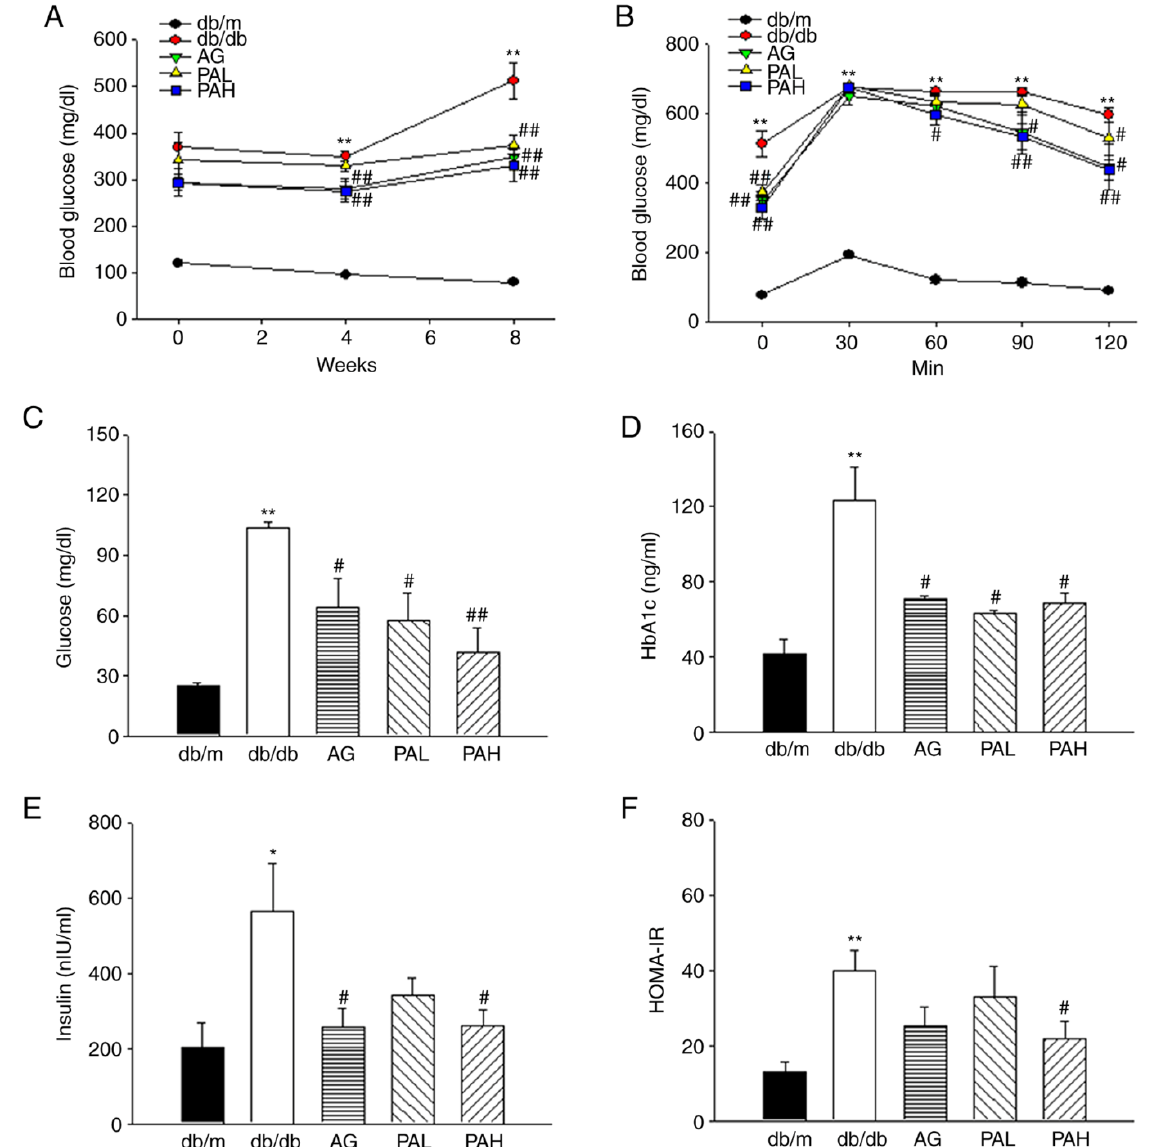
Figure 3. Effects of ER-PA on blood glucose ( A ); oral glucose tolerance test ( B ); glucose ( C ); HbA1c ( D ); insulin ( E ) and HOMA-IR ( F ). Values are expressed as mean ± standard error of the mean ( n = 8). * p < 0.05, ** p < 0.01 vs. db/m; # p < 0.05, ## p < 0.01 vs. db/db. PA , Polygoni avicularis ; HbA1c, hemoglobin A1c; HOMA-IR, insulin resistance index; AG, db/db mice daily treated with 20 mg/kg aminoguanidine; PAL, db/db mice daily treated with a low concentration (10 mg/kg) of ER-PA; PAH, db/db mice treated daily with a high concentration (50 mg/kg) of ER-PA.